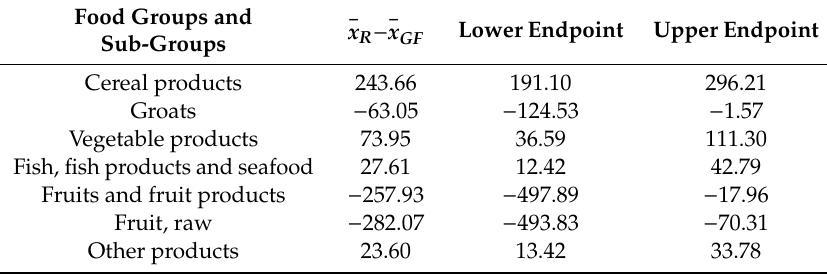
Table 5. Lower and upper endpoints of a 95% confidence interval for the di ff erence between mean regular and gluten-free